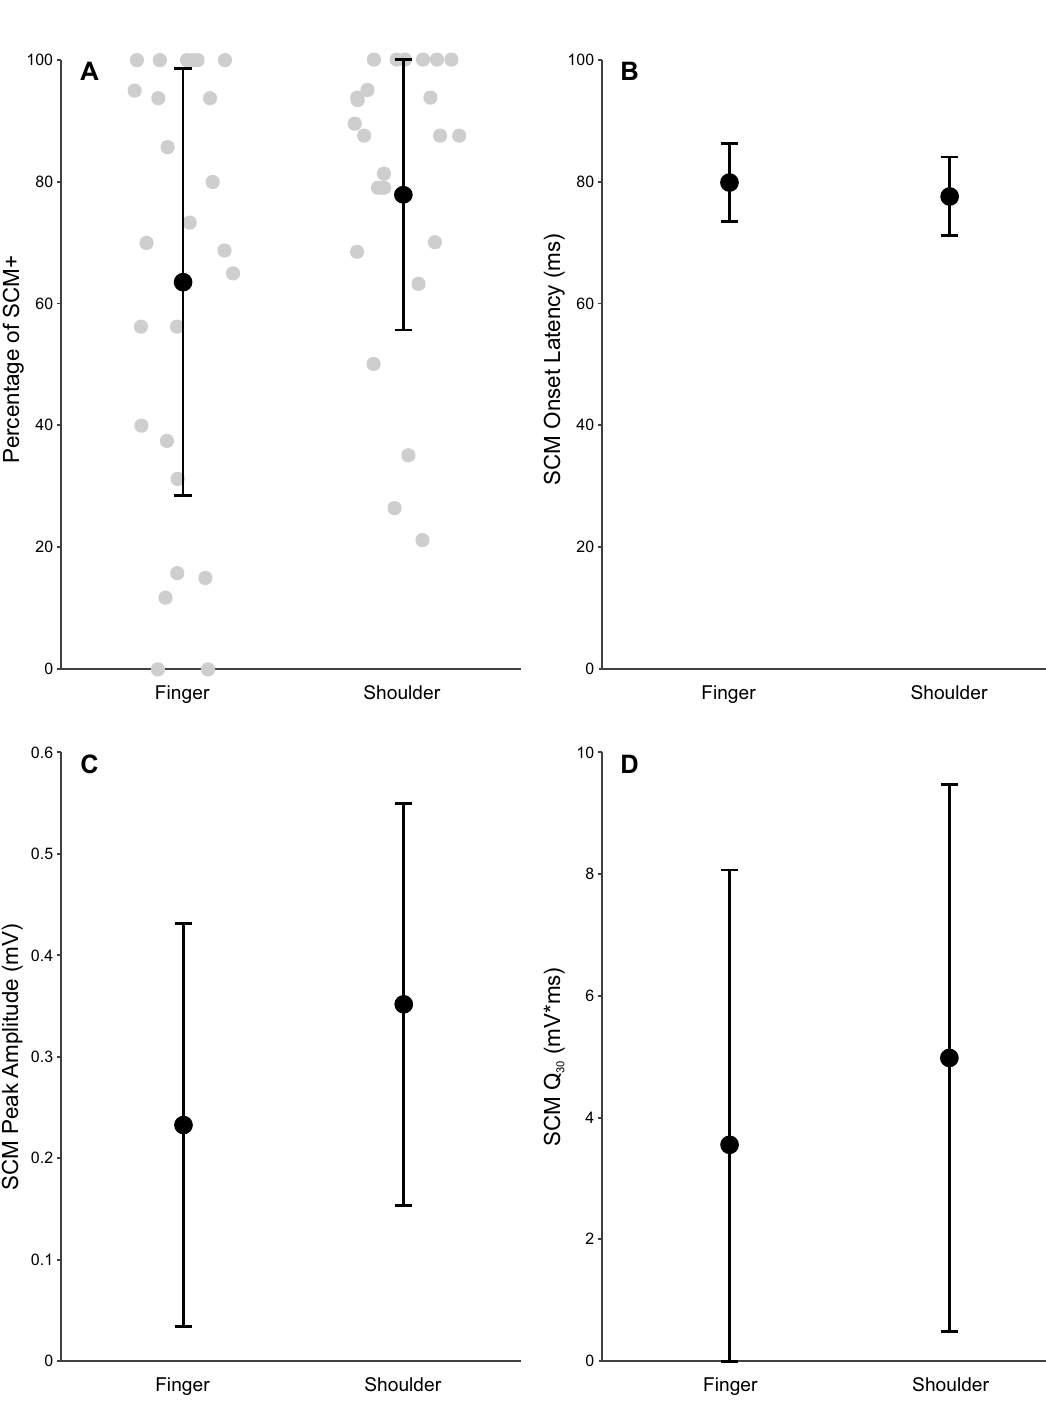
Figure 3. Startle-related EMG variables for trials in which sternocleidomastoid activation was present (SCM +) for the shoulder and finger responses. Panel ( A ) shows the proportion of SCM + trials, which was significantly higher for the shoulder task (p = 0.003) (n = 25 participants). Panel ( B ) shows the SCM onset latency in ms (n = 554 data points), which was not significantly different between movement types (p = 0.058). Panels ( C ) and ( D ) (n = 554 data points each) show SCM peak amplitude (mV) and SCM Q 30 (mV*ms), which were both larger for the shoulder versus the finger task (p < 0.001 for peak amplitude, p = 0.016 for Q 30 ). Error bars in panel ( A ) represent SD and grey dots show individual participant means; for all other panels error bars represent 95%